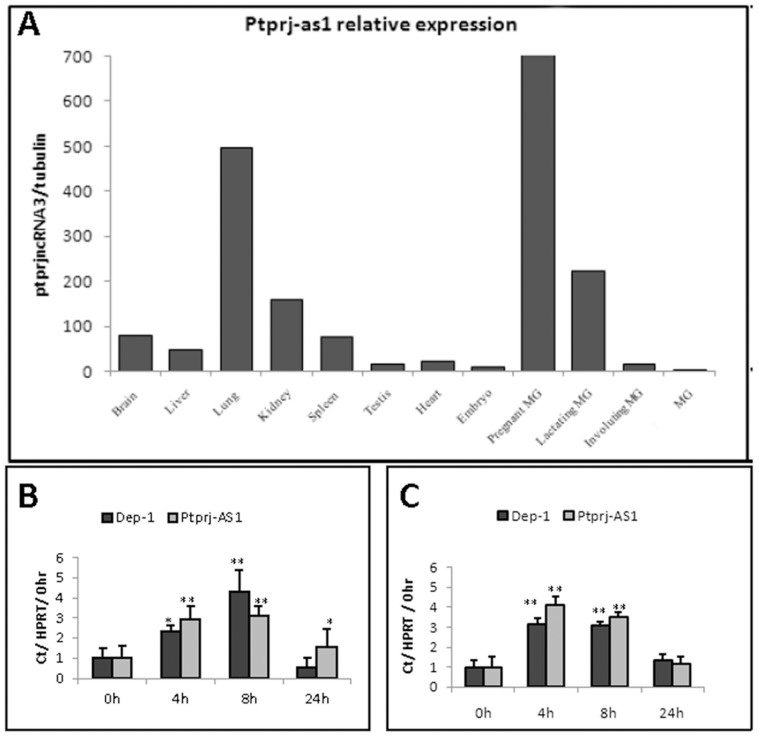
Expression of Ptprj-as1 in murine tissues and in response to TRL ligands.A: Expression of Ptprj-as1 in murine tissues. B, C: Ptprj and Ptprj-as1 mRNA expression in BMMs in response to LPS (B) or Pam3Cys (C). mRNA expression was quantified by qRT-PCR and expressed as fold change compared with untreated (0h). Plots represent mean fold change +/− SD; n = 3. Significance values were determined by one-way analysis of variance (ANOVA). *denotes p<0.05; **denotes p<0.005; n = 3.